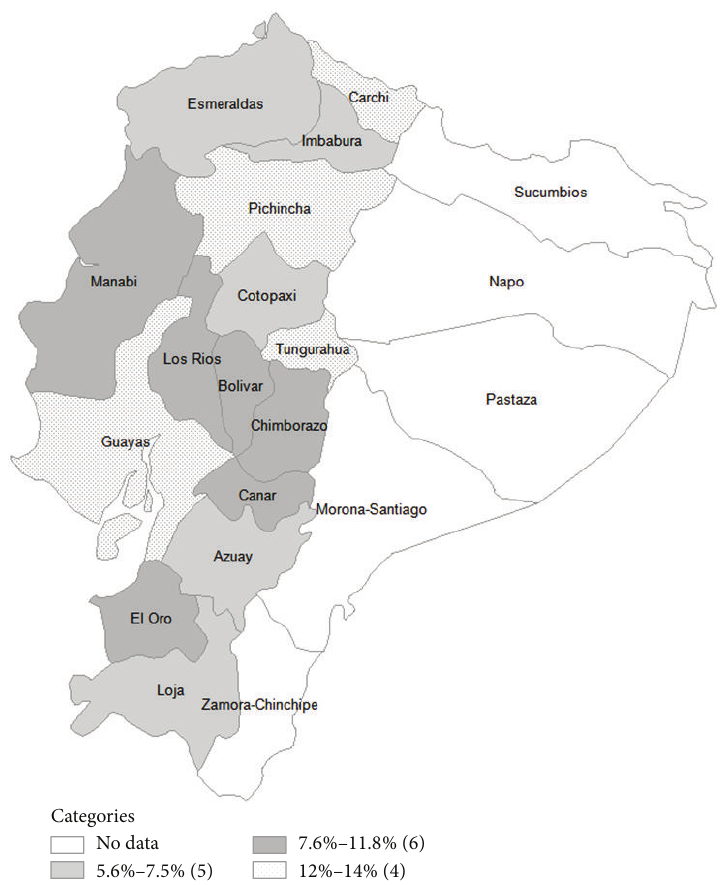
Figure 1: Fall-related injury prevalence rates by provinces in